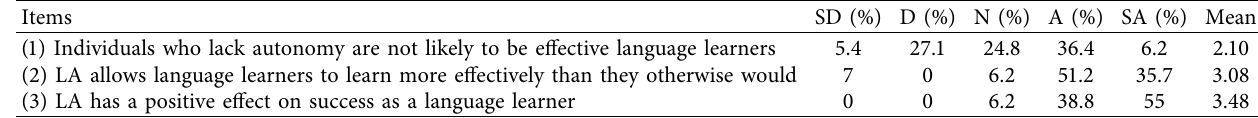
Table 7: Descriptive statistics of learner autonomy contribution to English